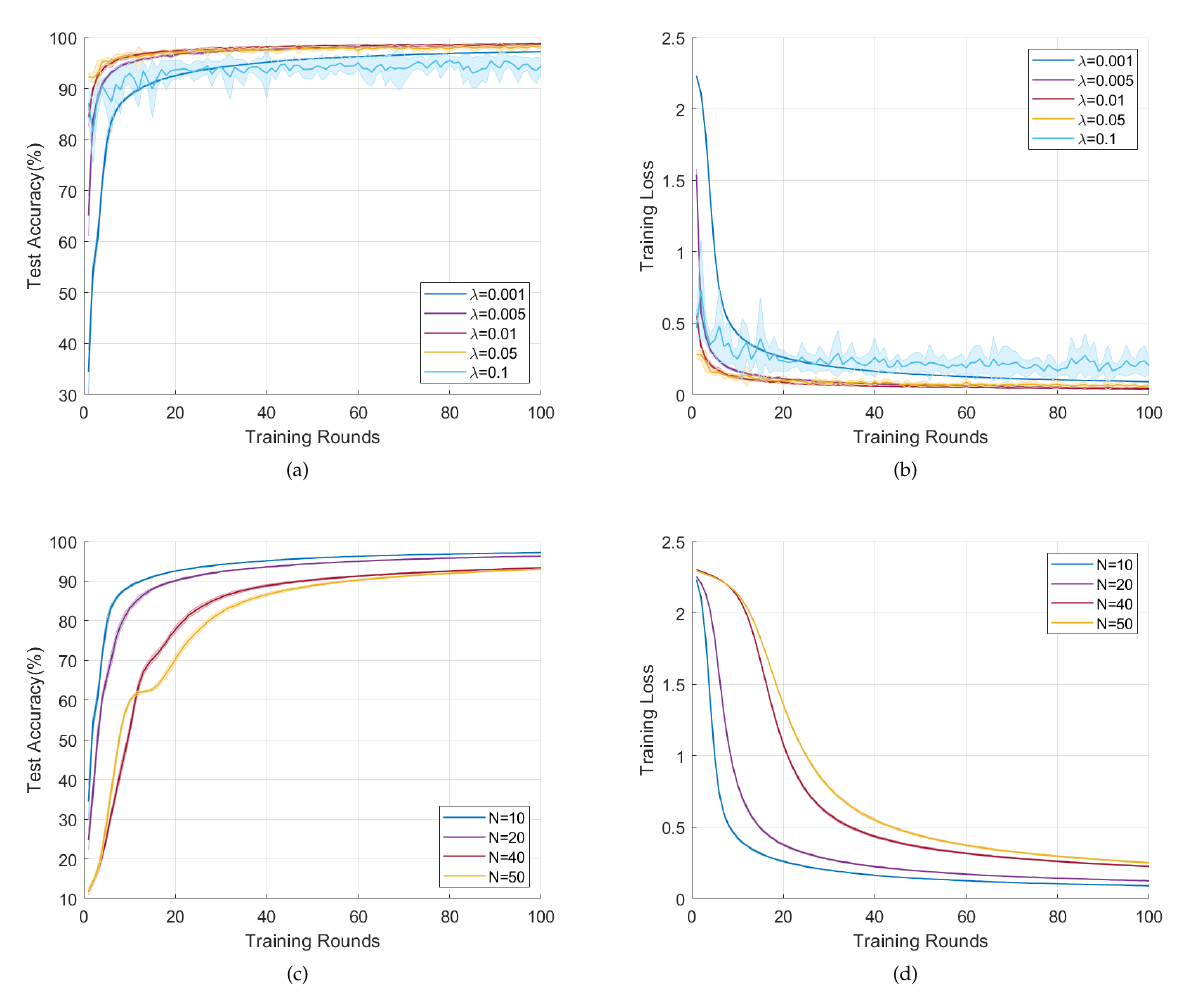
Figure 8. Performance vs learning rate and topology size. ( a ) Acc vs. λ ; ( b ) Loss vs. λ ; ( c ) Acc vs. N; ( d ) Loss vs.